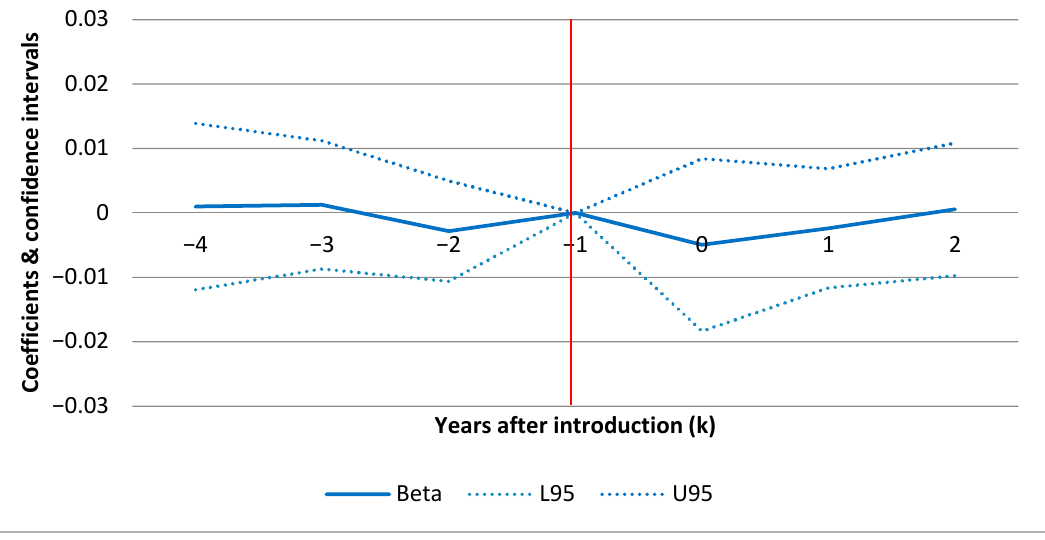
Figure 3. Yearly effects of POCT of HbA1c on ambulatory care, point estimates. Note: dotted lines represent 95% confidence intervals. Model includes year and clinic fixed effects and the full set of covariates from Table 6. 4.3. Parallel Assumption For both types of hospitalizations, the parallel assumption in F1 and F2 seems to be fulfilled. The justification is that there is no difference in outcomes (relative to the baseline year) between the treatment and the control group prior to the POCT introduction after taking into account covariates (zero within CI prior to intro). For ambulatory care visits, there are minor exceptions for single years ( 𝑘 (cid:3036) = −4 𝑎𝑛𝑑 𝑘 (cid:3036) = −3 ). This means that 4 and 3 years prior to the introduction, patients from the POCT clinics had more ambulatory care visits in contrast to the control group. 4.4. Robustness We tested a binary treatment definition. The estimates were similar to the results for the continuous definition. This indicates that the results are not driven by the choice of treatment